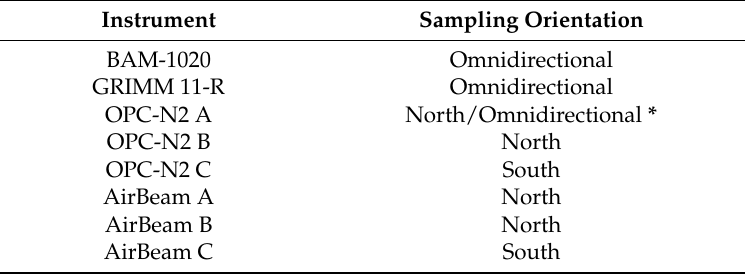
Table 1. Instrument sampling